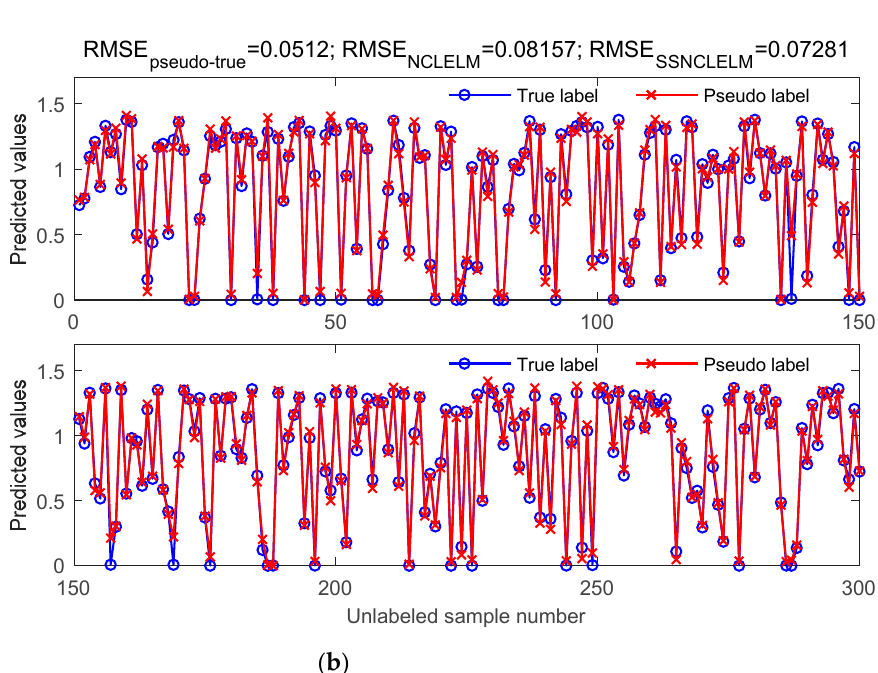
Figure 8. Comparison of the real and pseudo labels estimated by the proposed pseudo-labeling optimization method from ( a ) Example run 1, and ( b ) Example run 2. RMSE pseudo–true is the fitting accuracy between the pseudo and true labels, and RMSE NCLELM and RMSE SSNCLELM denote the prediction accuracy of the NCLELM, before and after including the pseudo-labeled data,